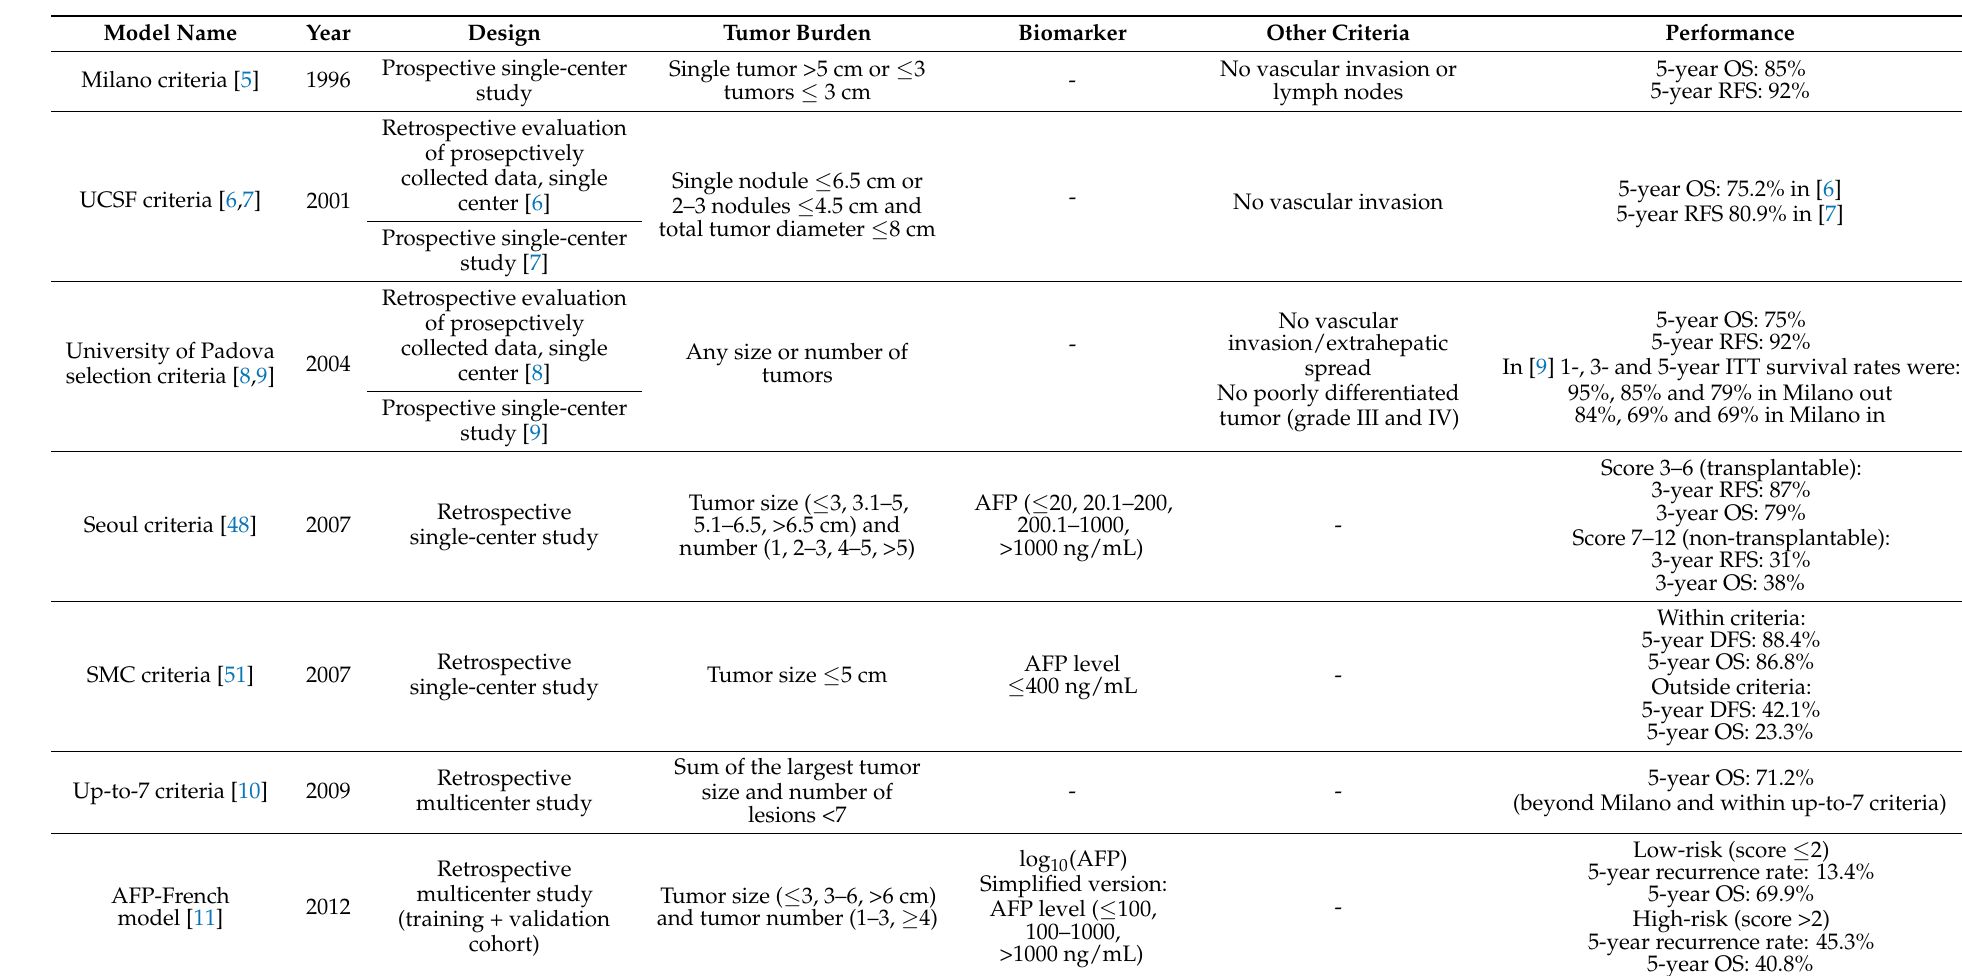
Table 1. Proposed pre-transplant selection criteria and scoring